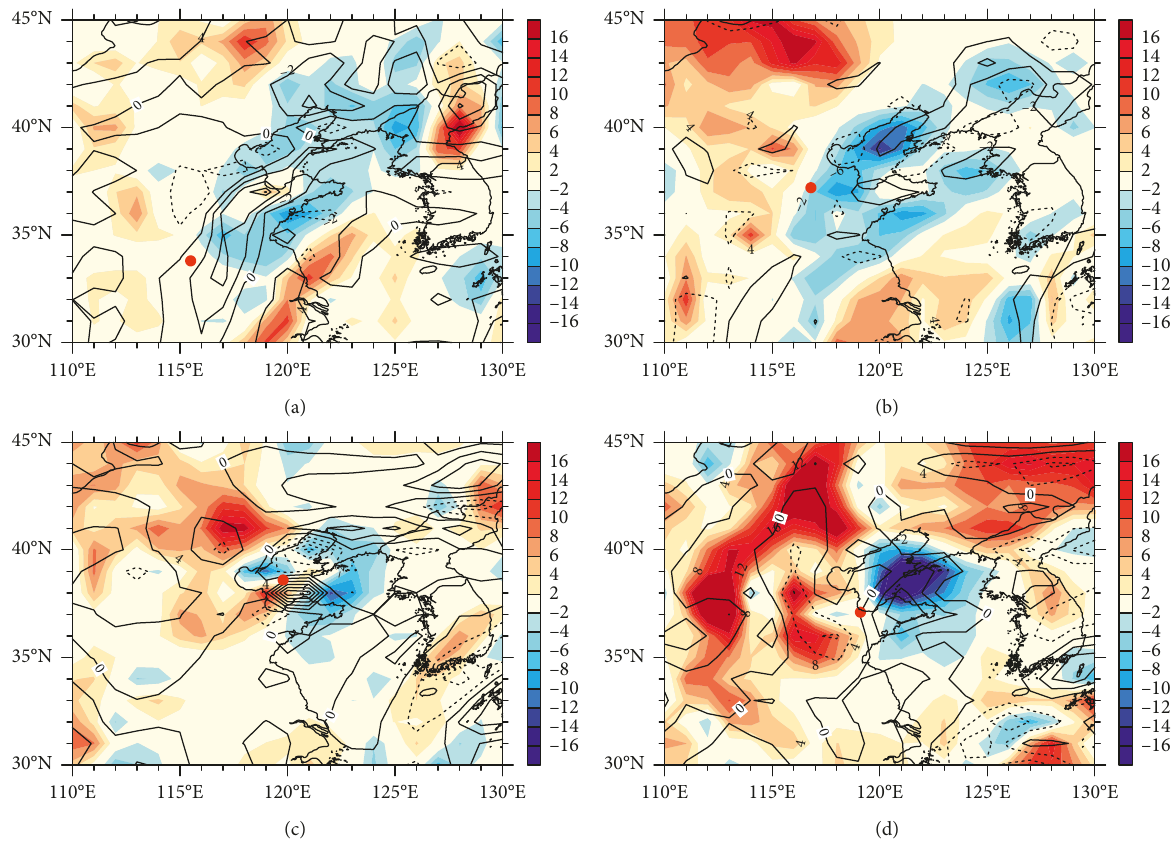
Figure 9: Vorticity advection at 700 hPa (contour: × 10 9 /s 2 ) and temperature advection at 850hPa (shading: × 10 5 K/s): (a) 0000 UTC 14 August; (b) 1200 UTC 14 August; (c) 0000 UTC 15 August; (d) 1200 UTC 15 August. The red dots represent the location of